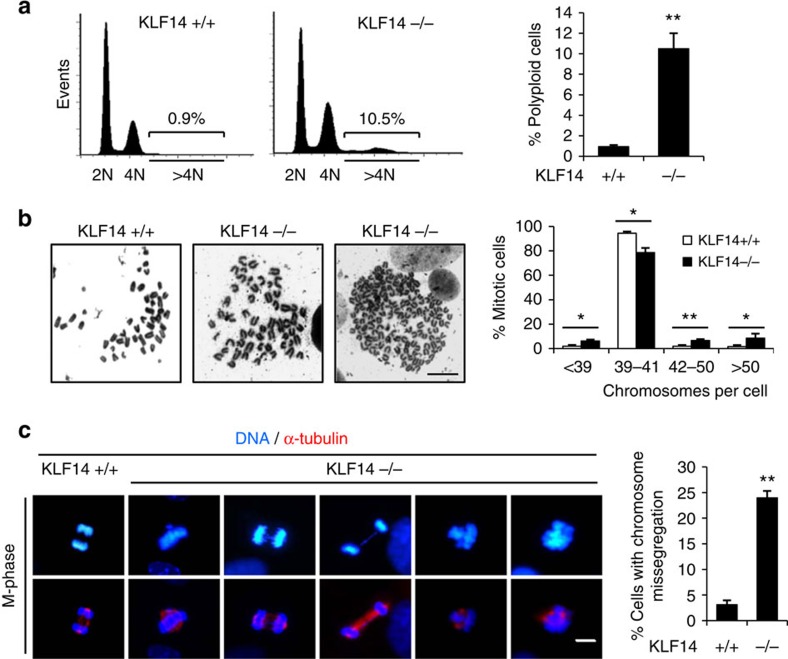
Loss of KLF14 induces genome instability.(a,b) KLF14 KO induces aneuploidy. (a) Cells with >4N DNA content increased in KLF14-KO MEFs. Representative flow cytometry profiles of KLF14-WT and -KO passage 3 (P3) MEFs stained with propidium iodide. Bar graph shows the mean percentage of cells with DNA content >4N. Data represent the mean±s.d. from three separate experiments, **P<0.01. (b) Representative images show Giemsa staining of metaphase chromosome spreads in KLF14-WT and -KO P3 MEFs (scale bar, 10 μm). Graph shows the fraction of MEFs with different numbers of chromosome per cell. One hundred metaphase spreads were counted for each group. Data represent the mean±s.d. from three separate experiments, *P<0.05, **P<0.01. (c) KLF14 KO induces chromosome instability. Spindles and DNA in KLF14-WT and -KO P3 MEFs were stained with α-tubulin (red) and 4,6-diamidino-2-phenylindole (DAPI, blue), and visualized by fluorescence microscopy. Representative images show mitotic chromosomal abnormalities including micronucleus, bridges, laggards and scattering in KLF14-KO MEFs (scale bar, 10 μm). Bar graph shows the percentages of MEFs with mitotic chromosomal abnormalities. More than 100 mitotic cells were counted for each group; data represent mean±s.d., **P<0.01.